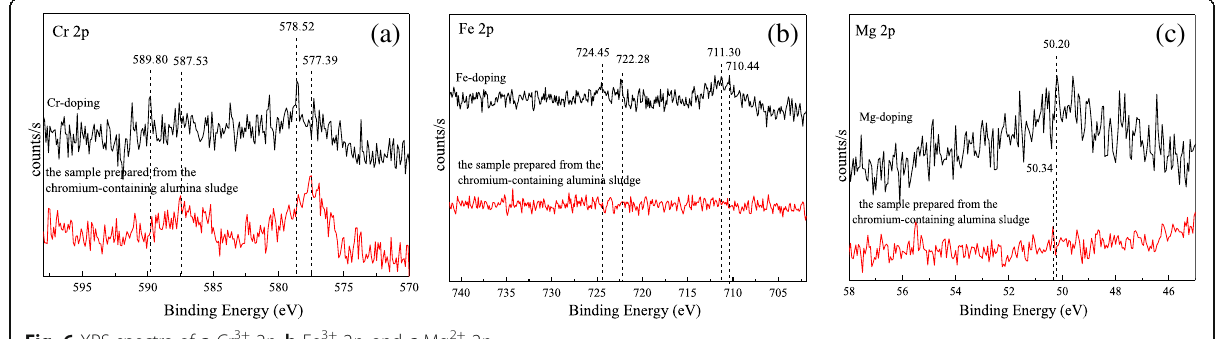
Fig. 6 XPS spectra of a Cr 3+ 2 p , b Fe 3+ 2 p , and c Mg 2+ 2